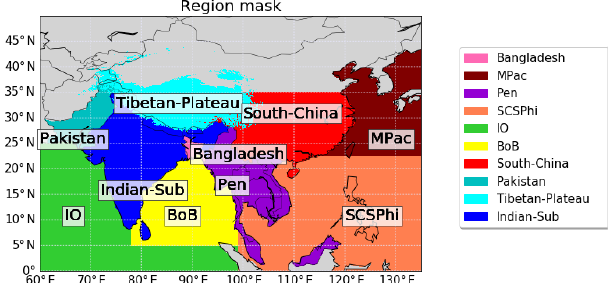
Figure 3. Source region mask for the AMA area. In colour: In- dian subcontinent (Indian-Sub), Tibetan Plateau (Tibetan-Plateau), South China (South China), Pakistan (Pakistan), South East Asia peninsula (Pen), South China Sea and Philippines (SCSPhi), Bangladesh (Bangladesh), North China (North China), Bay of Ben- gal (BoB), mid-Pacific (MPac), Indian Ocean